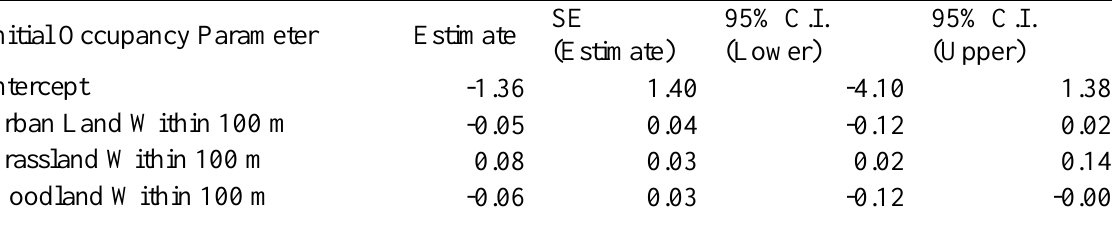
Table A3.F. Third-highest-ranking multi-season occupancy model (AIC AIC weight=0.12) for Western Meadowlarks along 47 transmission line study sites in